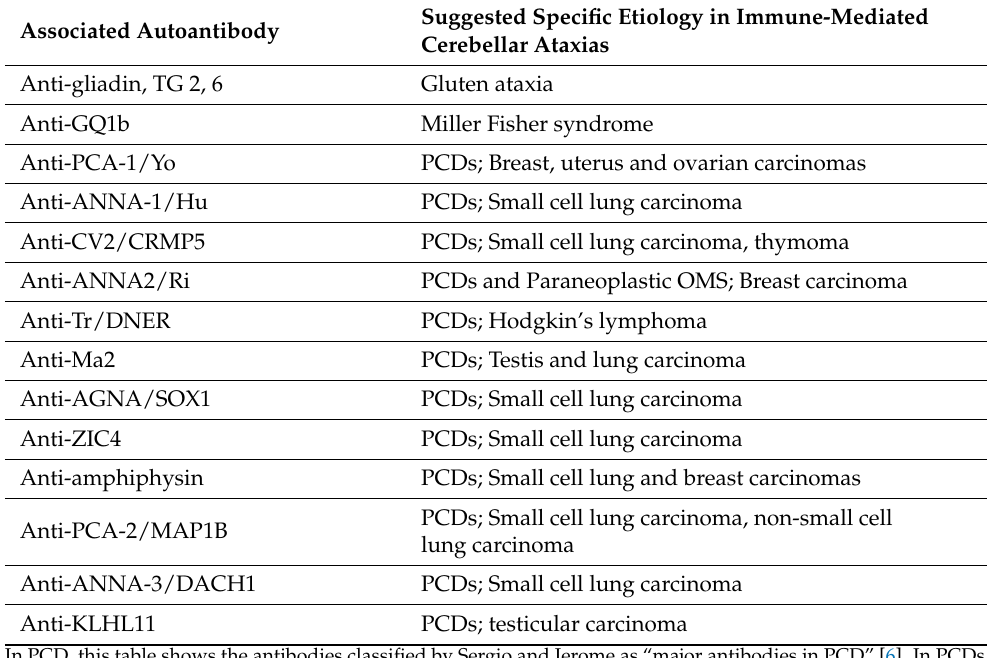
PCDs; testicular